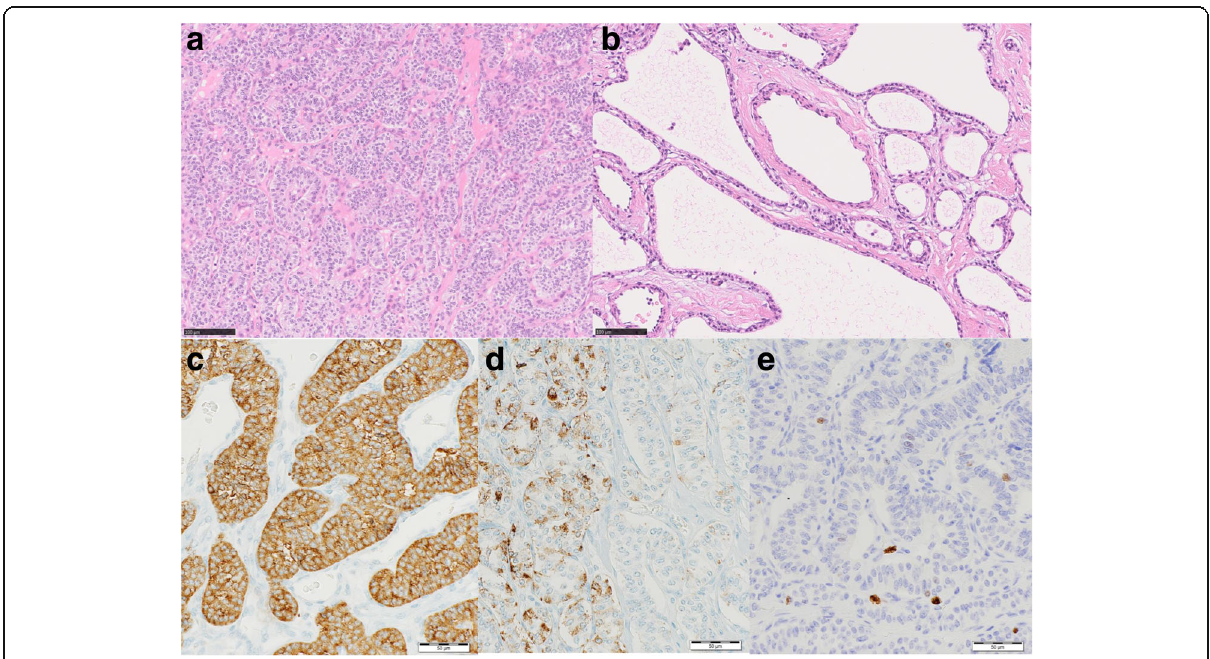
Fig. 6 Microscopically, the tumor in the tail of the pancreas showed a trabecular architecture with salt-and-pepper chromatin, eosinophilic cytoplasm, and abundant microvasculature ( a ). The cysts were serous cystadenomas lined with glycogen-rich cuboidal to flattened epithelial cells with clear cytoplasm and uniform round nuclei ( b ). Immunohistochemically, the tumor cells stained positive for synaptophysin ( c ) and focally positive for chromogranin A ( d ). The Ki-67 labeling index was 1% ( e